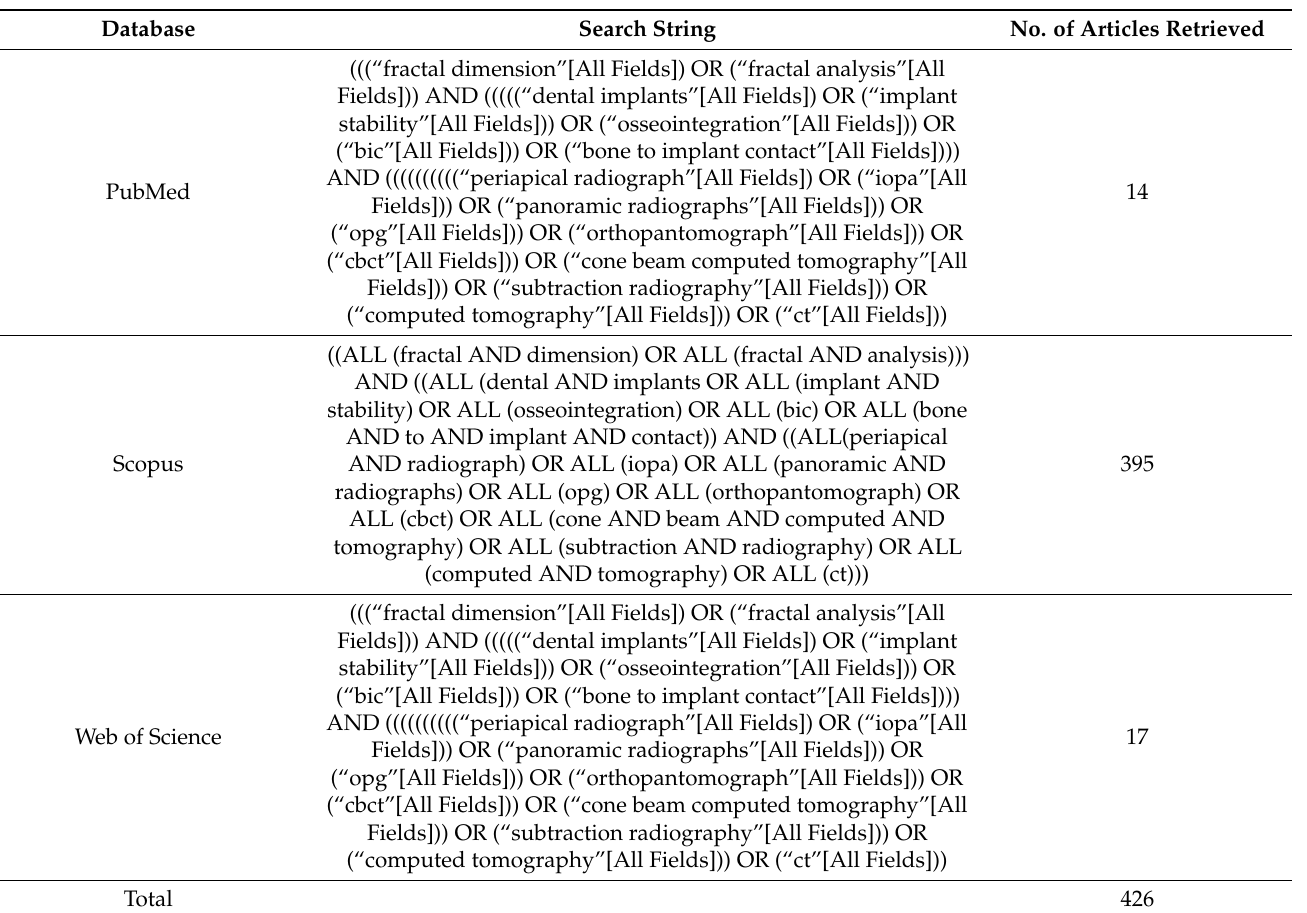
Table 1. Search Strategy for each electronic